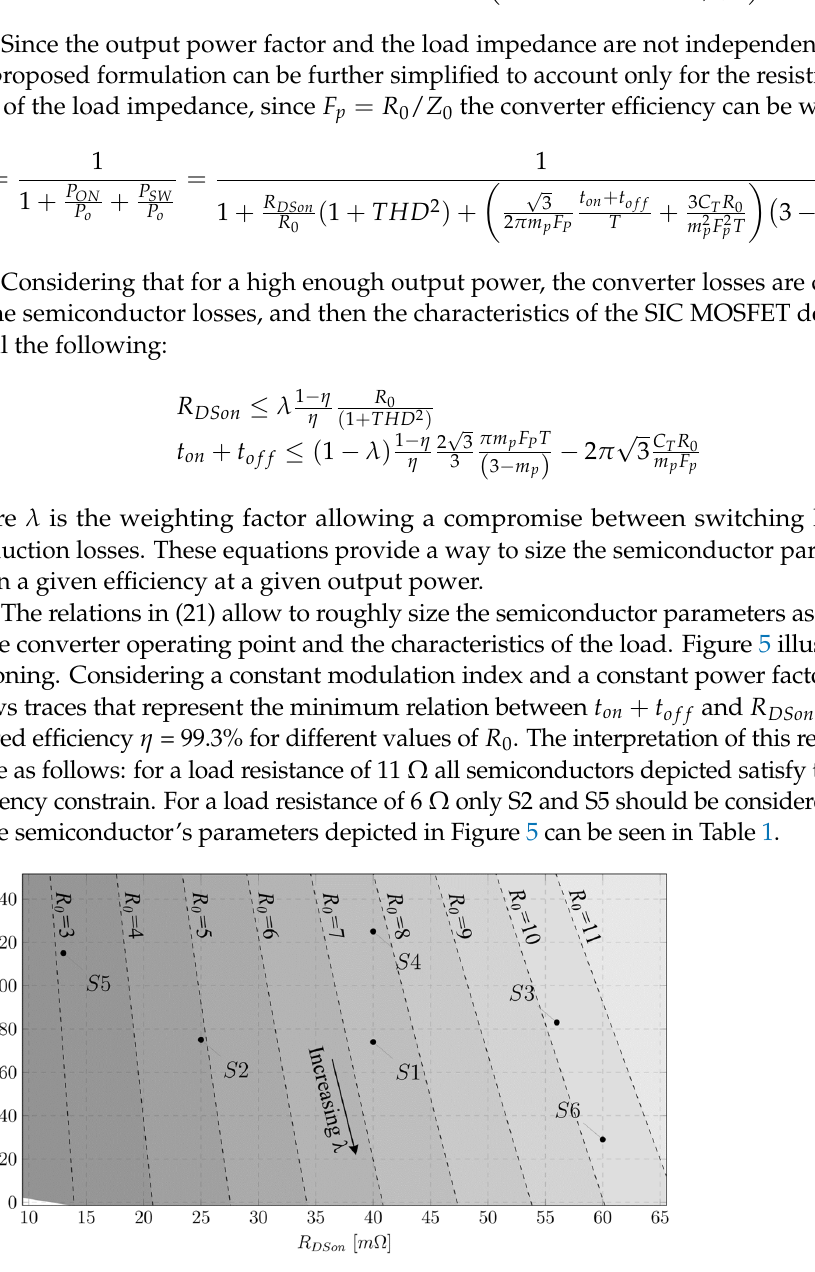
Figure 5. Relation between the SiC MOSFET turn-ON plus turn-OFF times with the channel ON-state resistance for a minimum efficiency of 99.3% at diffent values of the load resistance at constant power factor and modulation index. ( R 0 resistance in Ω